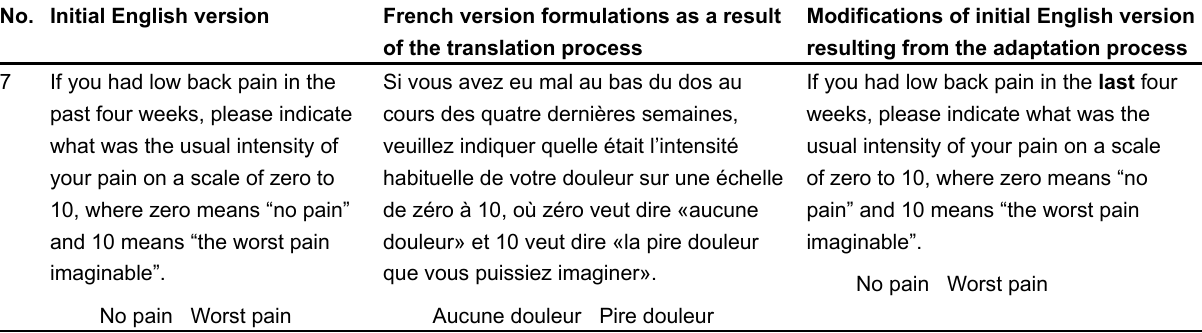
Table 1. Results of the translation of the Delphi DOLBaPP questionnaire from English to French ( continued ) No. Initial English